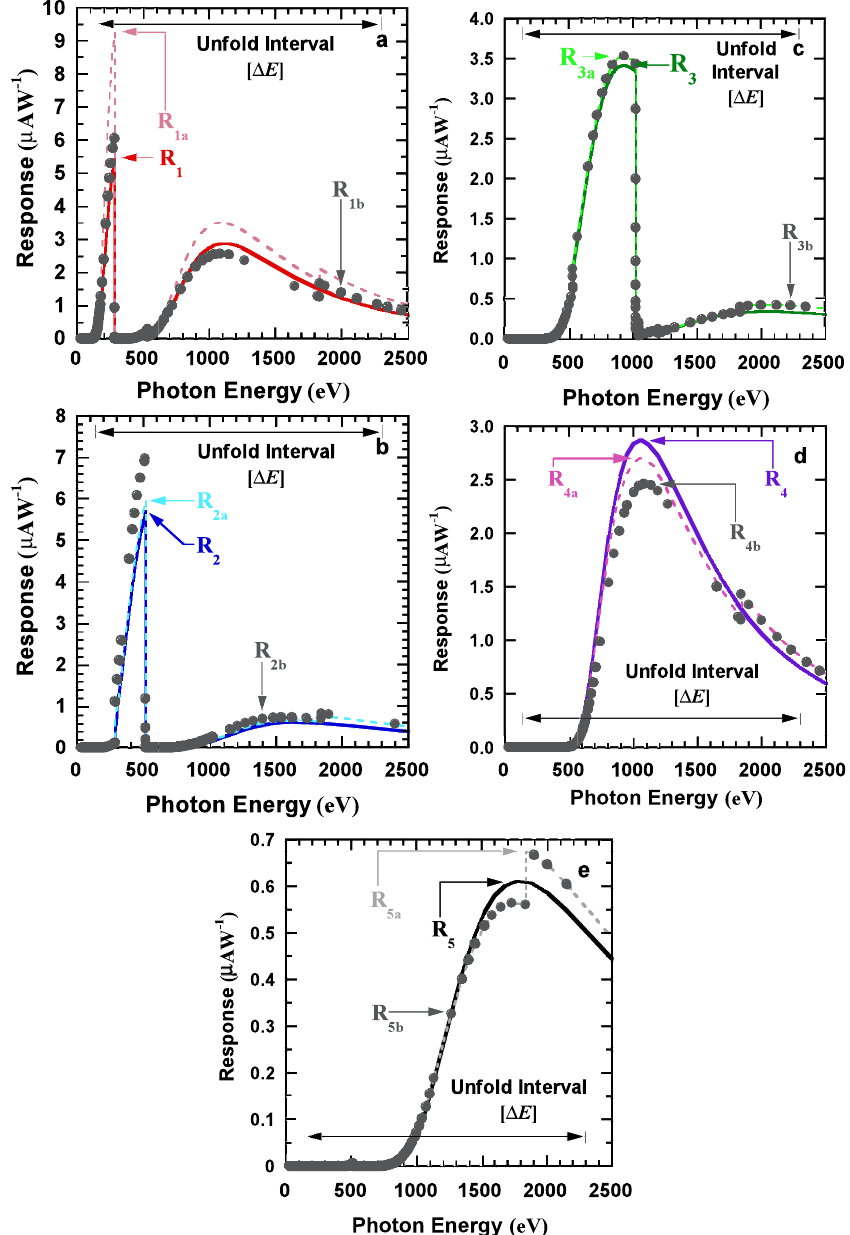
FIG. 2. Stability and reproducibility of the channel responses. The three curves in each frame are curve fits to calibrational x-ray data (not shown). Each frame includes (a) the reference calibration R ð E Þ after several months’ service, and (c) a calibration R R ia R and R indicate a drift in the diagnostic between calibrations. The jump in the sensitivity of R i ia to Si adsorbed onto the XRD’s from the vacuum system. A comparison of R with different XRD’s and filters. The unfold interval, ½ (cid:1) E (cid:7) ¼ ½ 137 ; 2300 (cid:7) eV , is indicated in each